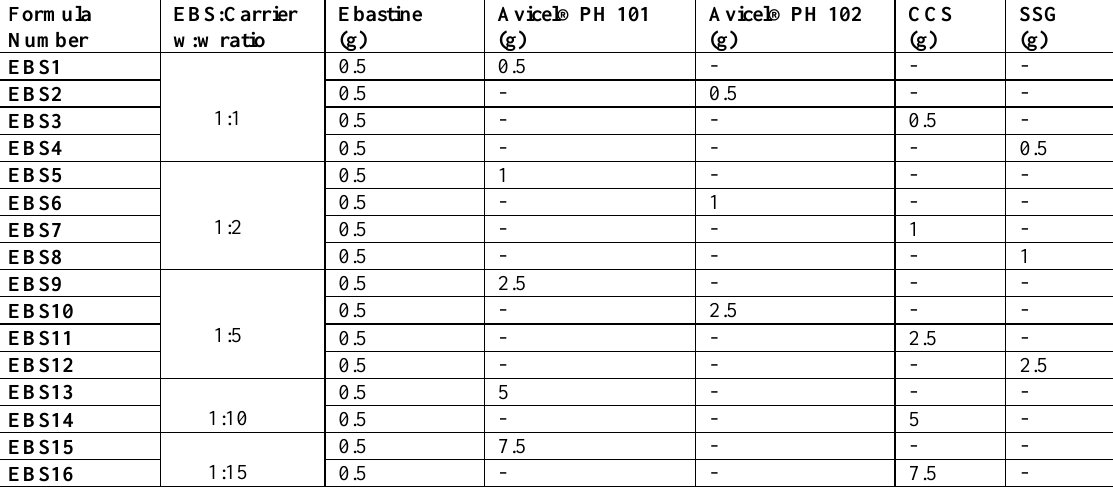
Table 1. Composition of different EBS SSD formulas